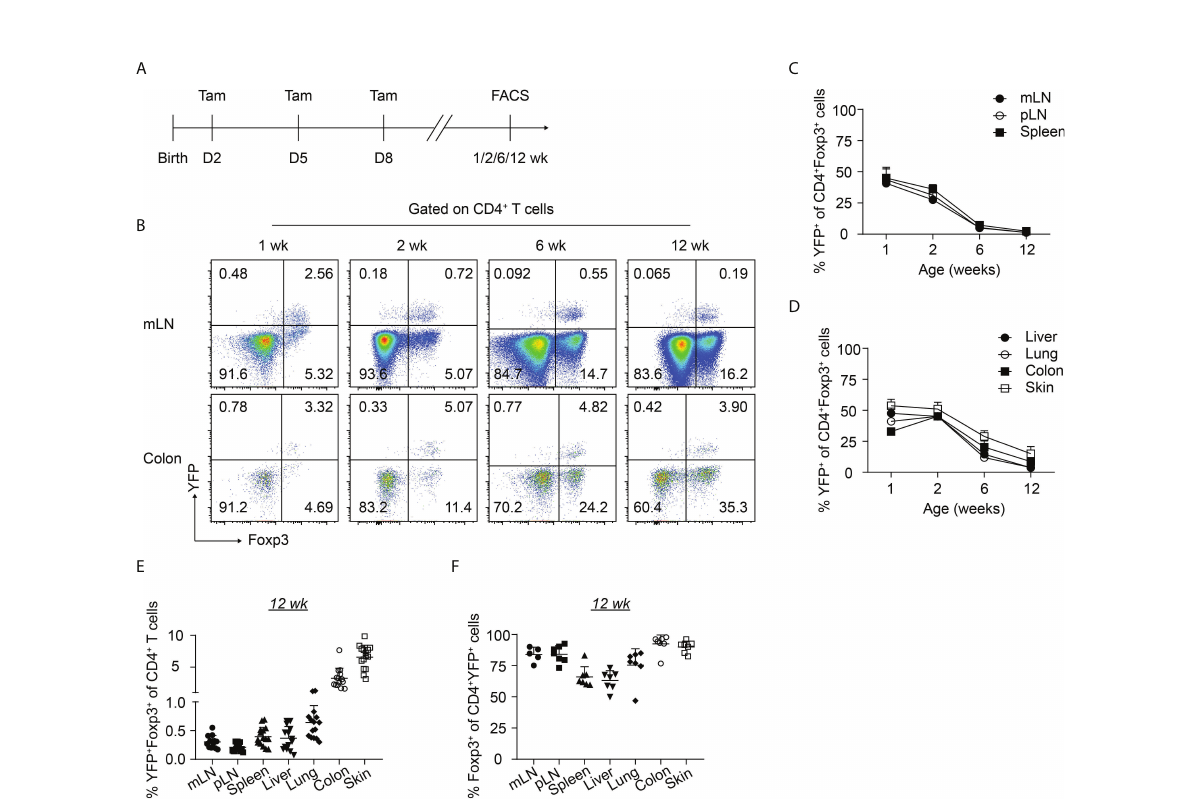
FIGURE 1 Kinetics of neonatally-tagged Tregs in different organs. Foxp3 eGFPCreERT2 xROSA26 STOP-eYFP mice received repetitive intragastric tamoxifen injections at days 2, 5 and 8 after birth, and were sacri fi ced at indicated time points (1, 2, 6, and 12 weeks corresponding to days 8, 15, 43, and 85 after birth, respectively). Single-cell suspensions from mLN, pLN, spleen, colon, skin, liver, and lung were analyzed by fl ow